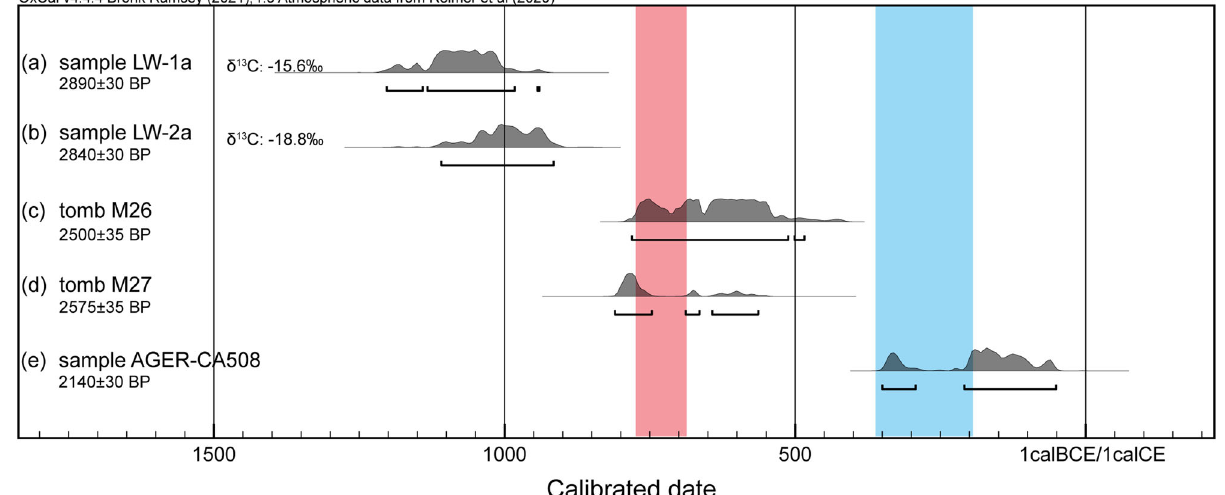
Fig. 6 The radiocarbon dating results. a and b are the calibrated dates for the lead white sample LW-1a and sample LW-2a from tomb M26 in the Liangdaicun site, respectively; c and d are the calibrated dates for tomb M26 and M27, respectively (Chen et al., 2009); e the calibrated dates for the lead white sample AGER-CA508 in ancient Greece (Beck et al., 2018). The bars underneath the probability distributions are the 95.4% con fi dence intervals. The red column represents the supposed burial dates of tombs M26 and M27 according to the archeological context. The blue column represents the burial date of sample AGER-CA508 (Beck et al.,